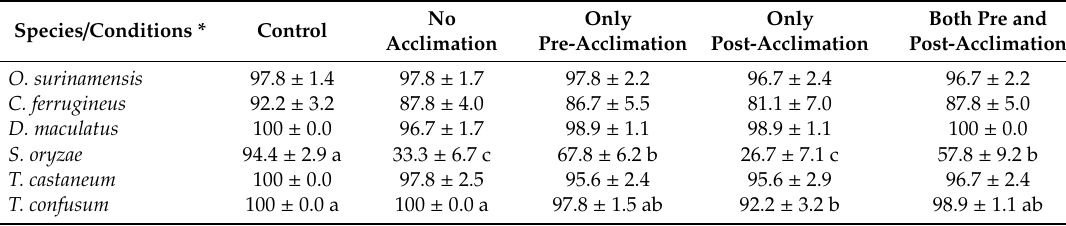
Table 2. Mean adult survival (100 ± standard error (SE)) of six di ff erent stored-product beetle species after exposure to 0 ◦ C for 7 d, with di ff erent pre and post-exposure temperatures. Pre-acclimation indicates a gradual 7d decrease of the temperature from 25 to 0 ◦ C, post-acclimation indicates a gradual 7 d increase of the temperature from 0 to 25 ◦ C, control indicates that the insects were continuously kept at 25 ◦ C (within each row, means followed by the same lowercase letter are not significantly di ff erent; where no letters exist, no significant di ff erences were noted; HSD at